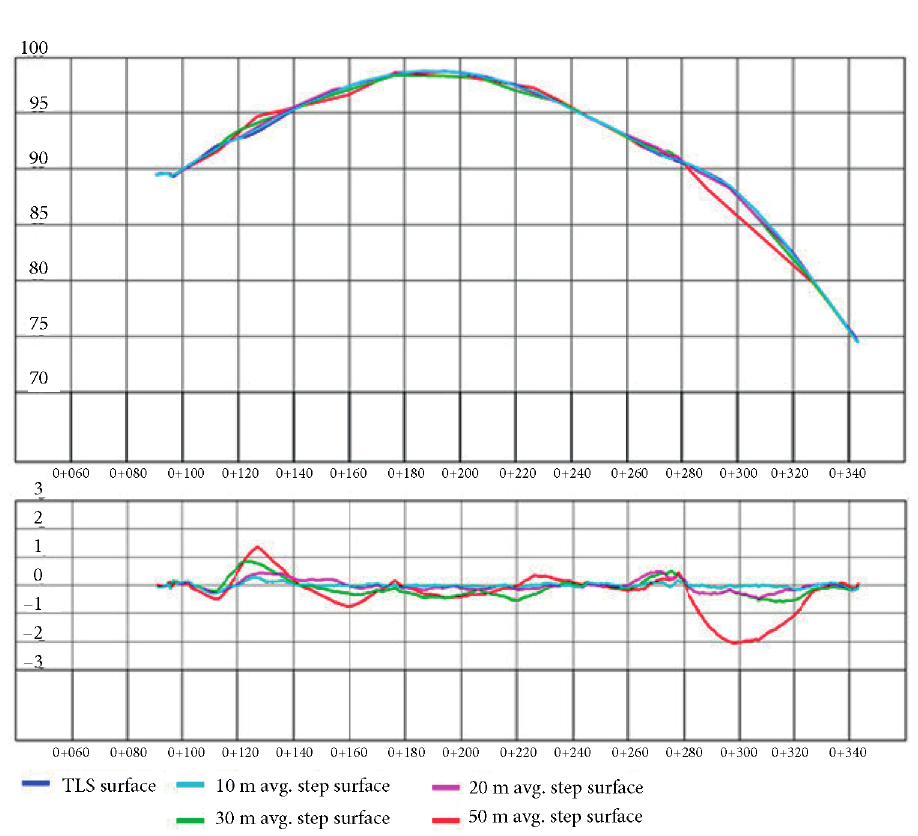
Fig. 11. Top: cross profiles A-A of the landfill ash-hill. Bottom: discrepancies of profiles A-A compared to TLS surface model of the landfill ash-hill Notes: Notice that the vertical scale of the TOP figure is 4 times exaggerated compared that of the horizontal scale. Notice that the vertical scale of the BOTTOM figure is 10 times exaggerated as compared to that of the horizontal